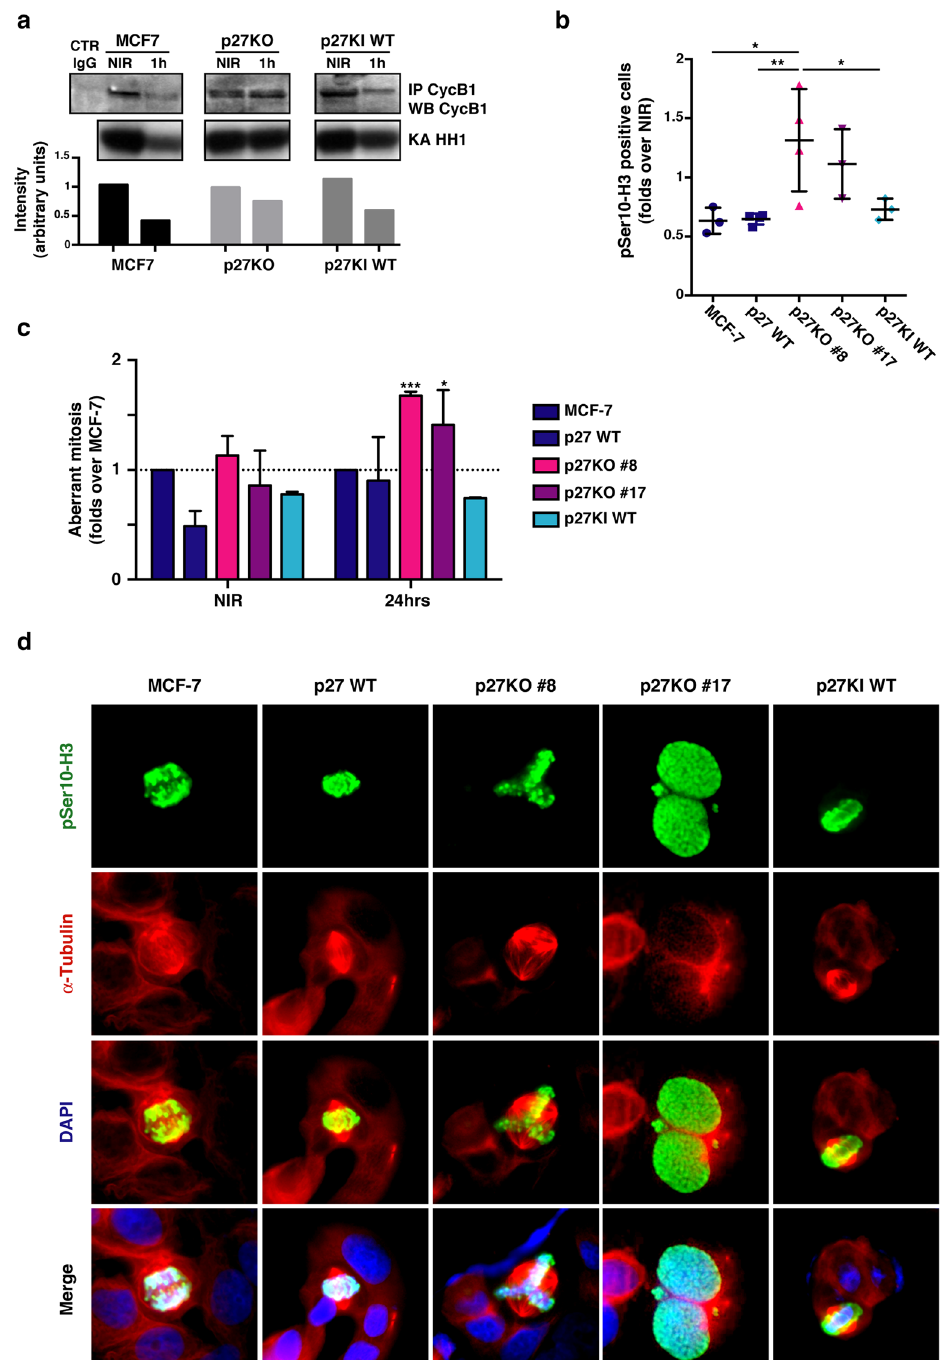
Figure 6. Luminal breast cancer cells KO for p27 are radio-resistant and accumulate mitotic defects. ( a ) Blots report the kinase assay (KA) on Histon H1 (HH1) by cyclin B1-associated CDK activity (lower panels). Upper panels show the level of immunoprecipitated cyclin B1 in the indicated cell clones. Bottom graph reports the quantification of HH1 phosphorylation, normalized for the quantity of immunoprecipitated cyclin B1. Full- length blot is shown in Supplementary Fig. S3. ( b ) Graph reports the quantification of pS3-H3 positive cells 2 hours after 2 Gy, evaluated by counting IF labeled cells, in indicated MCF-7 clones. Data are expressed as fold increase over NIR cells. ( c ) Graph reports the quantification of aberrant mitoses displayed by MCF-7 clones, in NIR or 24 hours after 2 Gy. Data are expressed as fold increase over the aberrant mitoses found in MCF-7 parental cells. ( d ) Representative pictures of cells reporting the above mentioned mitotic aberrations. Cells were stained for phospho-Ser10 Histon-H3 (pS10-H3) to identify mitotic cells (pseudocolored in green), α Tubulin (pseudocolored in red) to highlight the mitotic spindle and DAPI (pseudocolored in blue) to identify the cell nuclei. * Indicates a p < 0.05; ** p <